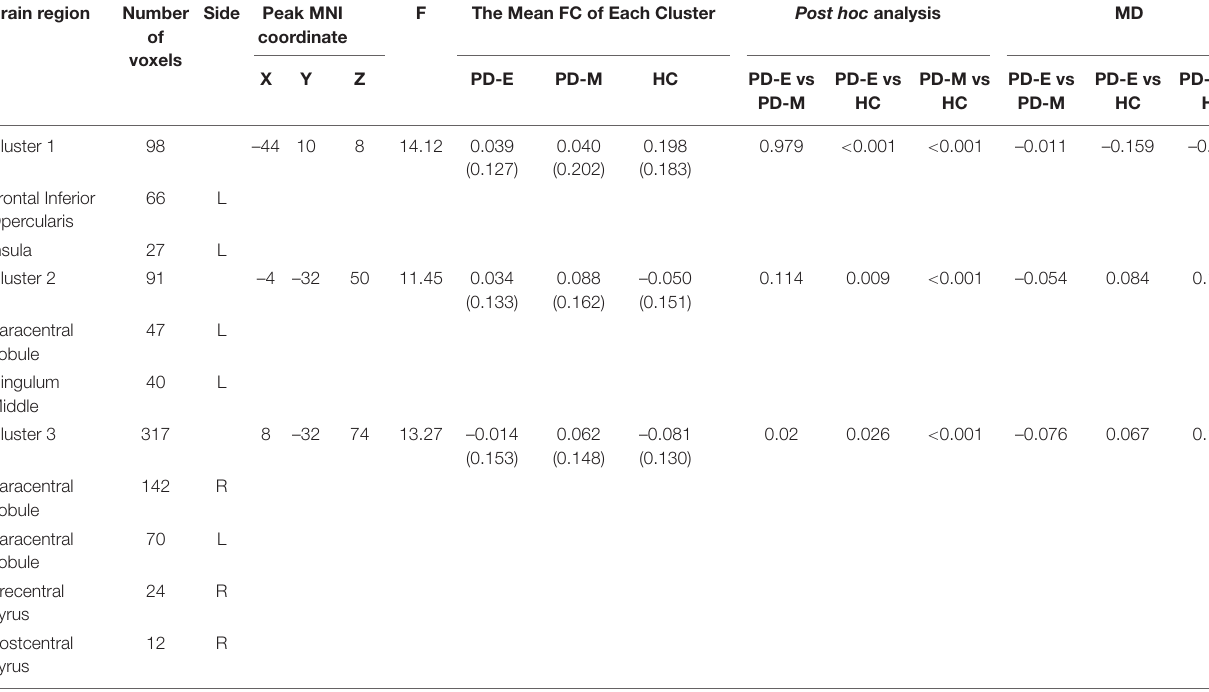
TABLE 2 | Anatomical location and post hoc comparison results of altered functional connectivity in significant brain regions.